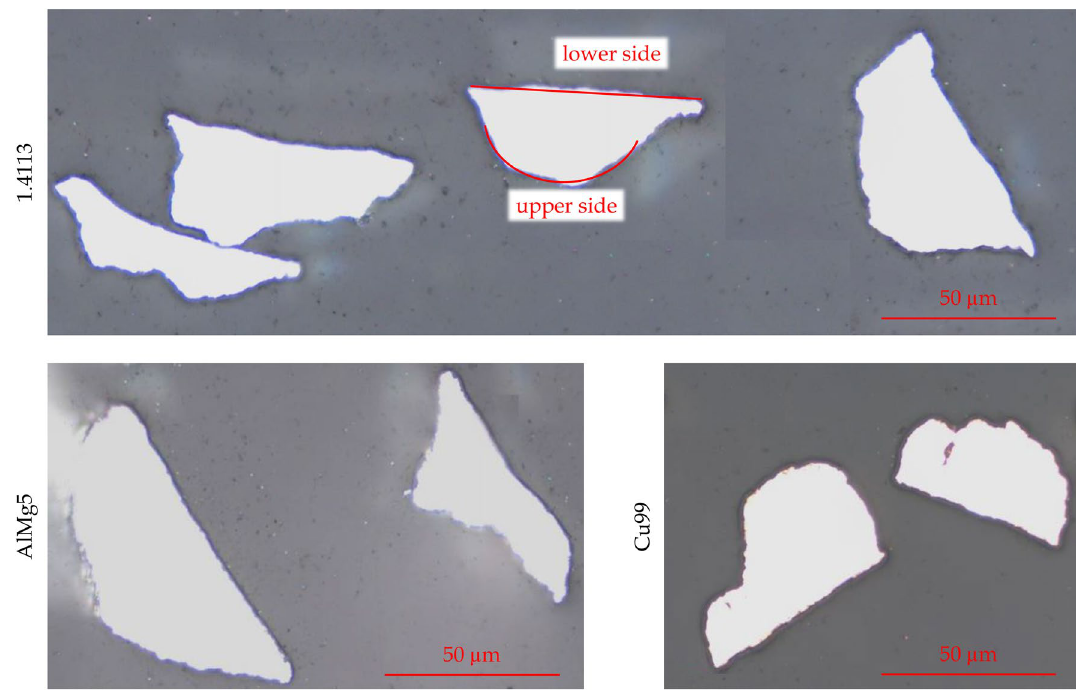
Fig. 7 Cross-sectional view of metal staple fibres; 1.4113 (a), AlMg5 (b) and Cu99